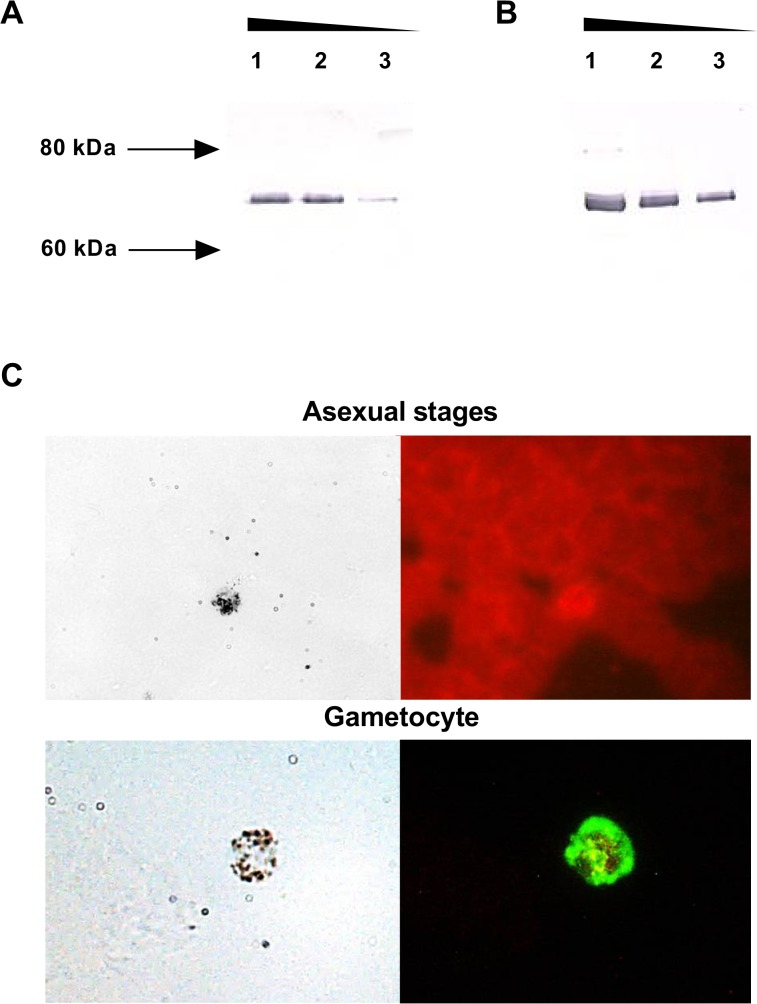
Recognition of parasite Pvs48/45 protein by sera of immunized monkeys.
A) Western blot assay using antigen extracted from pellet after iRBCs lysis in reduced conditions (β-mercaptoethanol). Lane 1, antigen (non-diluted); lane 2, antigen 1:2 diluted; lane 3, antigen 1:4 diluted. B) Western blot assay using antigen extracted from supernatant after iRBCs lysis in reduced conditions (β-mercaptoethanol). Lane 1, antigen (non-diluted); lane 2, antigen 1:2 diluted; lane 3, antigen 1:4 diluted. Triangles indicate increased concentration. C) Monkey IgG was reactive with Pvs48/45 on acetone-fixed smears of sexual blood stages of P. vivax with monkey sera containing antibodies to rPvs48/45. From left to right: parasite in light (left), parasite in epifluorescence (right).